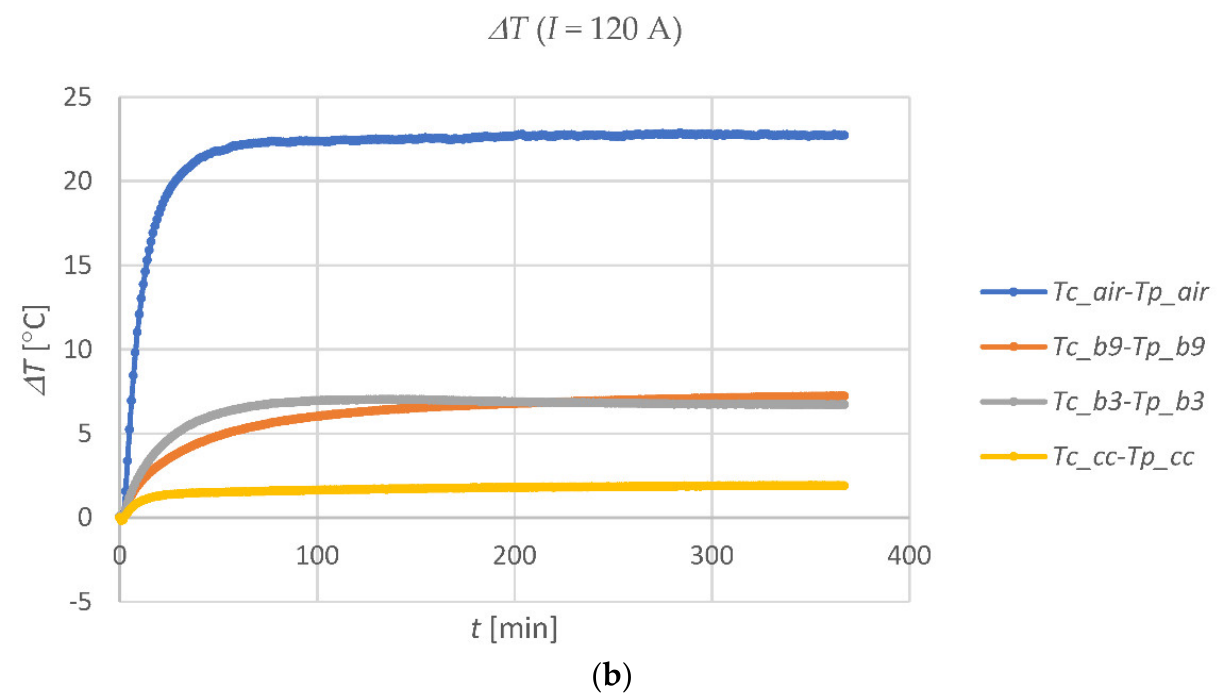
Figure 7. Changes in time of temperature differences between the cable and the pipe wall for individual casing pipes: ( a ) with a current of 60 A in the cable; ( b ) with a current of 120 A.